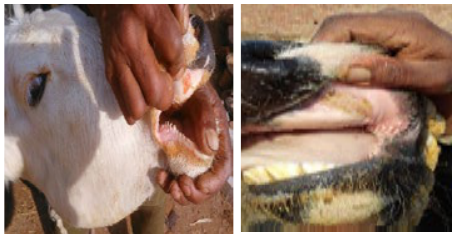
Figure.1. Showing lesions on the hoof and mouth epithelium during a FMD outbreak in District